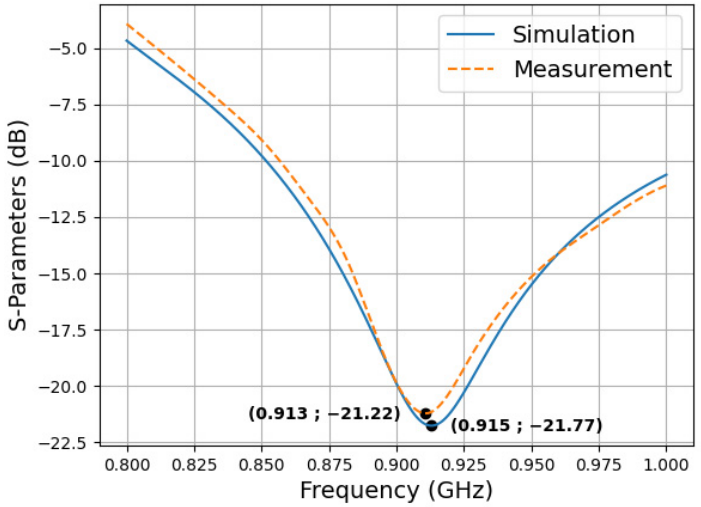
Figure 4. Collinear antenna’s S-parameter.